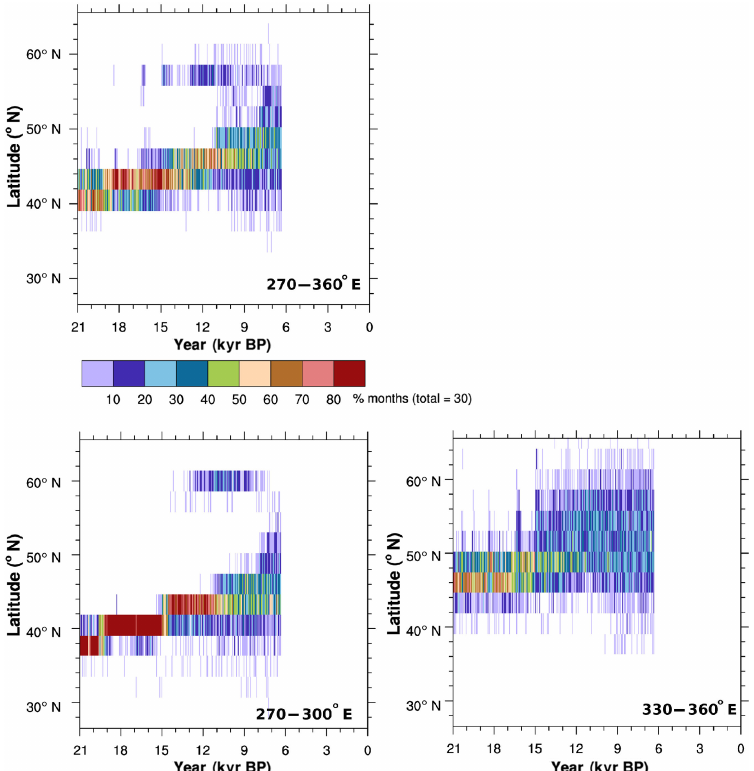
Figure A3. Frequency plots for North Atlantic eddy-driven-jet latitudes as a function of time for the un-accelerated transient deglacial